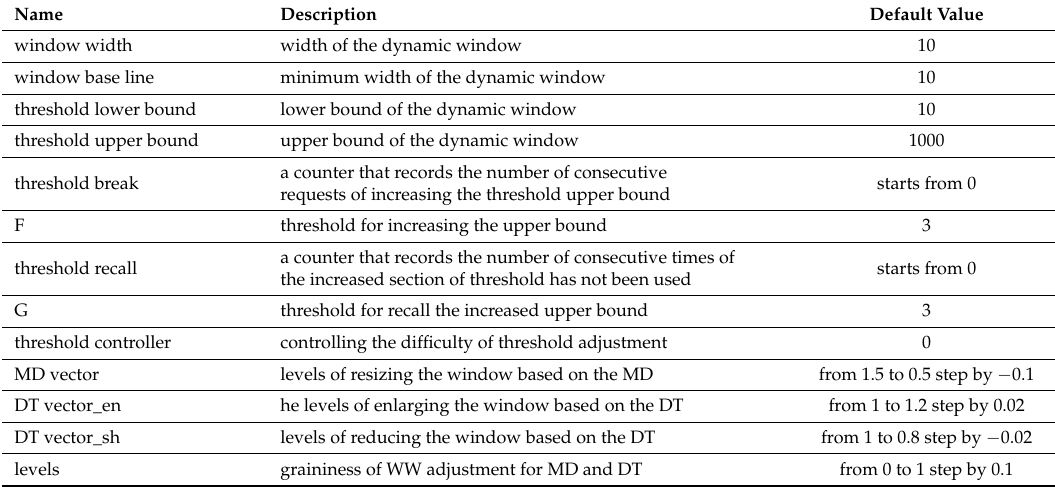
Table 1. Variables of